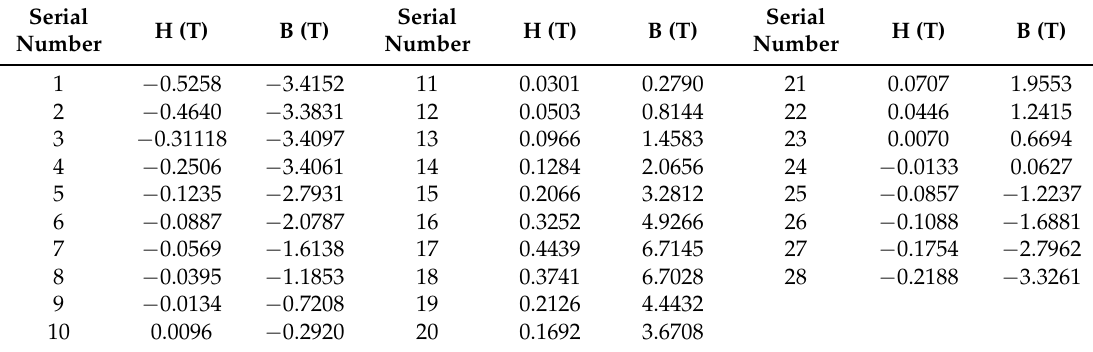
Table 1. Key original experimental